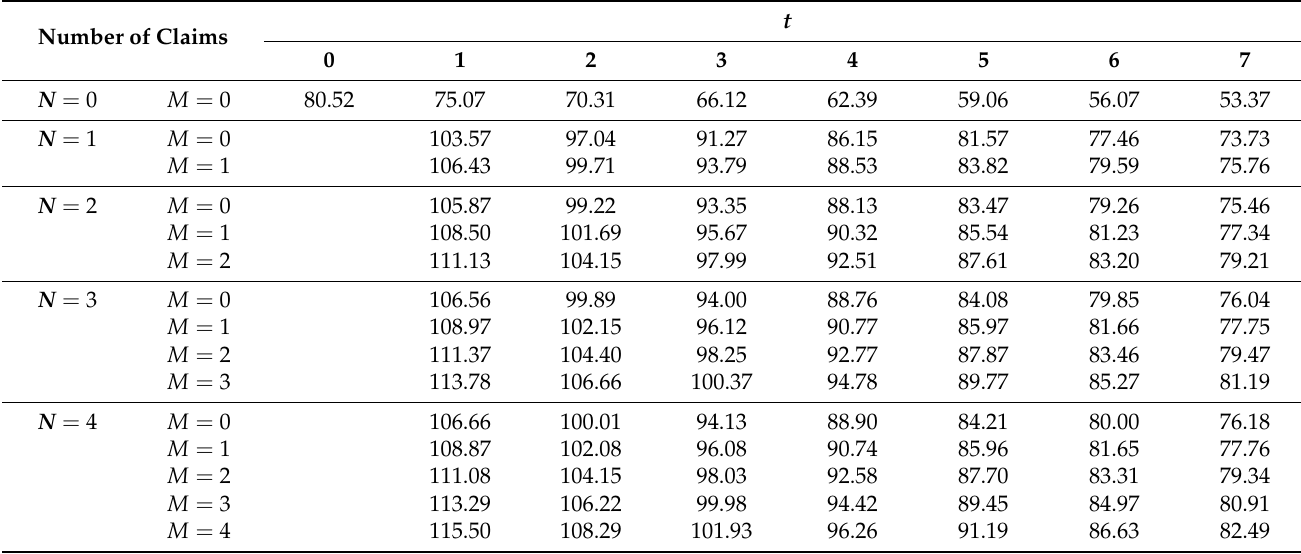
Table 5. Bonus-malus premiums based on Poisson binomial-Lindley beta distribution for the fre- quency component and gamma-Lindley distribution for the severity component with a total claim size of S = 400.